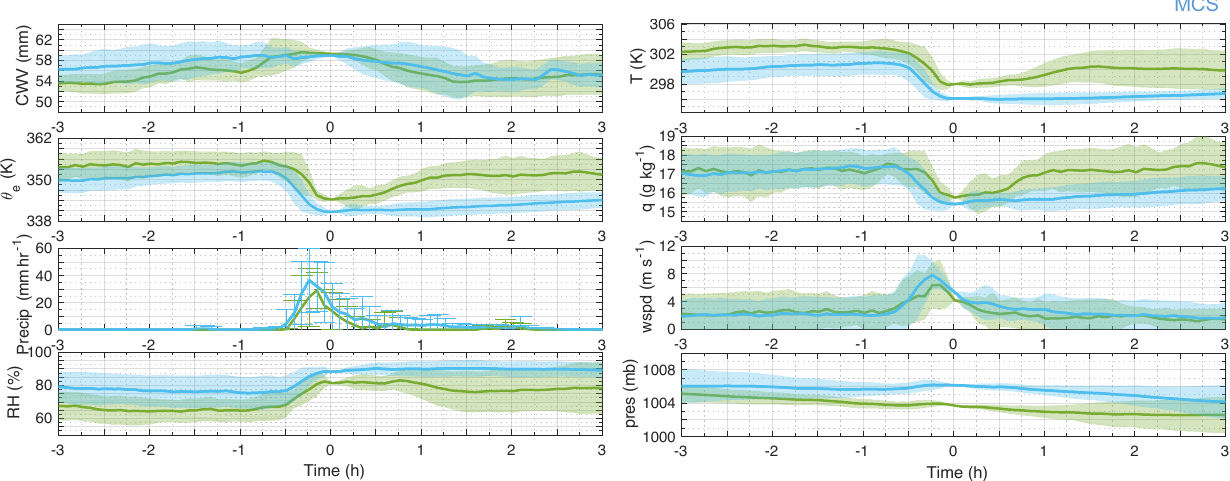
Figure 2. Composites of meteorological variables from the AOSMET station at site T3 3h leading and 3h lagging the minimum in equivalent potential temperature (0h; second panel) coincident with the passage of isolated cells (green) and MCSs (blue). Shading denotes ± 1 standard deviation of anomalies with respect to 0h; bars on precipitation are ± 1 standard deviation for each time interval. Standard errors would be smaller by a factor of 0.3 for isolated cells and 0.2 for